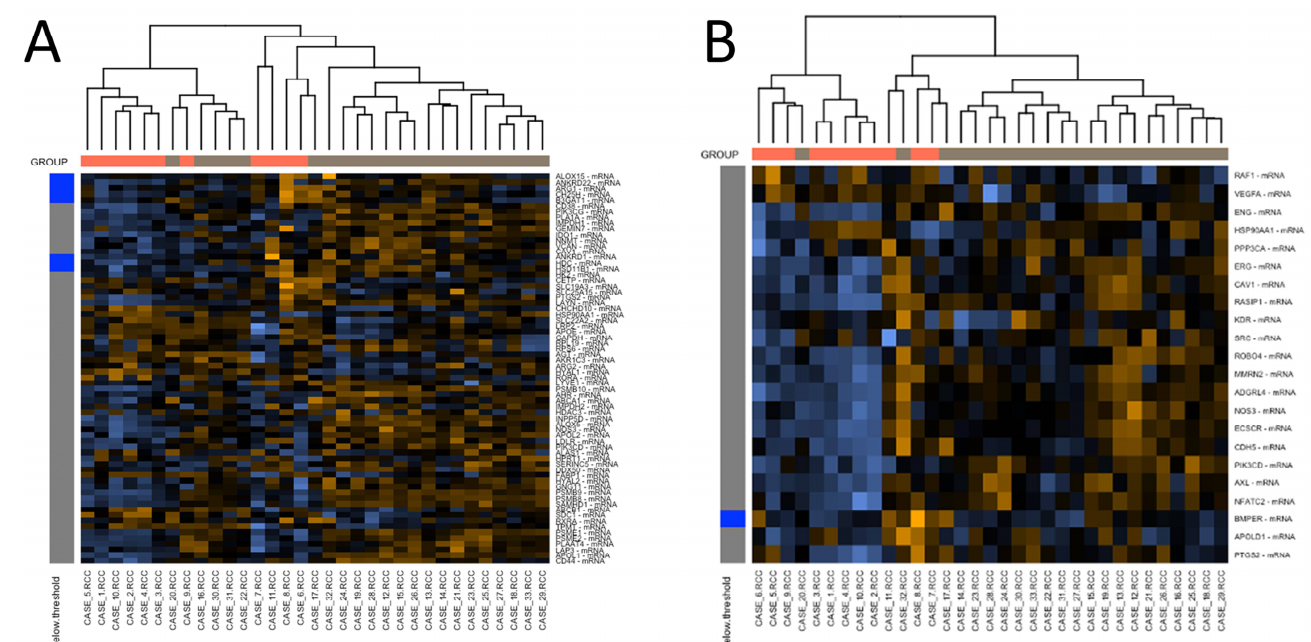
Figure 6. Heatmaps representation of the normalized genes included in the angiogenesis ( A ) and metabolism ( B ) pathway. In the angiogenesis pathway, ROBO4, PIK3CD, ENG, RASIP1, NFATC2, CDH5, NOS3, ADGRL4, AXL, ECSCR ( p < 0.01) MMRN2 , and Cav-1 ( p < 0.50) were the genes significantly more expressed in c-ABMR cases. In the metabolism pathway, the significantly more expressed genes in the c-ABMR group were APOL1, INPP5D, PSMB9, PSMB8, SAMHD1, ALOX5, PSME1, IDO1, PIK3CD, PSMB10, ABCA1, GNG11, PLA1A, PSME2, APOL2, NOS3, PLAAT4, AHR ( p < 0.01), HYAL2, CD44, LAP3, and Cav-1 ( p < 0.05). The rows represent the normalized genes, the columns the biopsy samples. Within the cells, orange intensity is proportioned to increasing expression of the corresponding gene’s mRNA, while blue intensity is related to lower expression levels. On the left side of the heatmap, genes’ expressions below the detection threshold are represented by blue boxes, while gray boxes represent the ones above the detection threshold. Above the heatmap, orange boxes represent the control group cases, while gray boxes the c-ABMR cases. The dendrogram represents levels of interdependence among